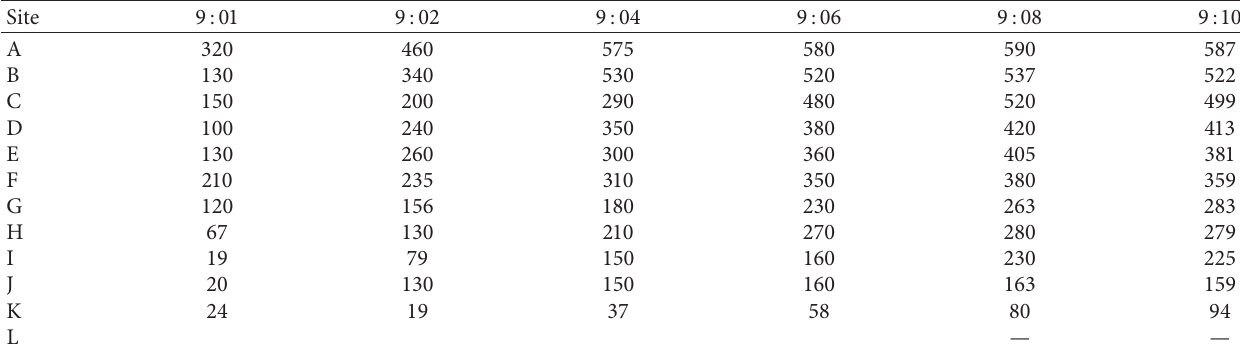
Table 5: Dynamic statistics of the number of reservations on each station.